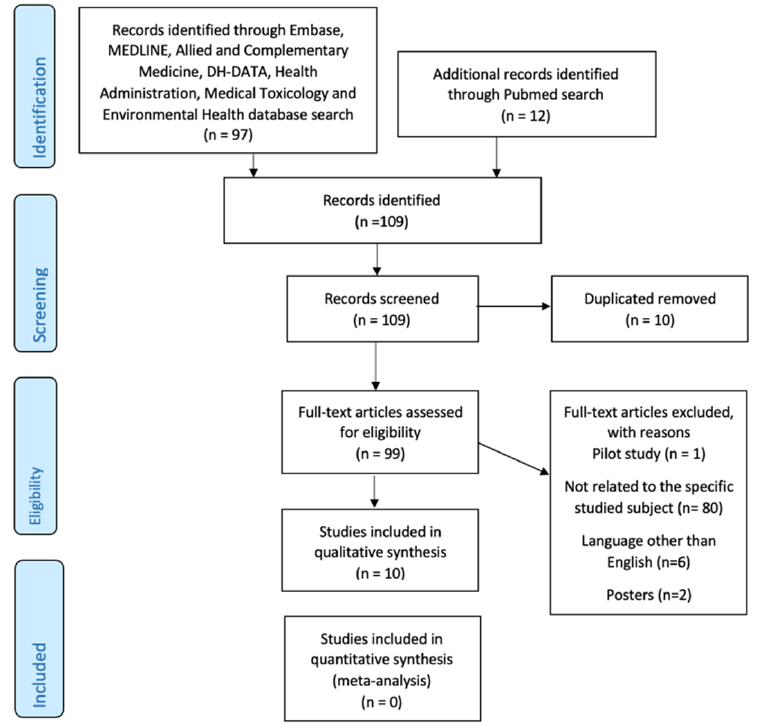
Figure 3. PRISMA flow diagram of the study selection process.